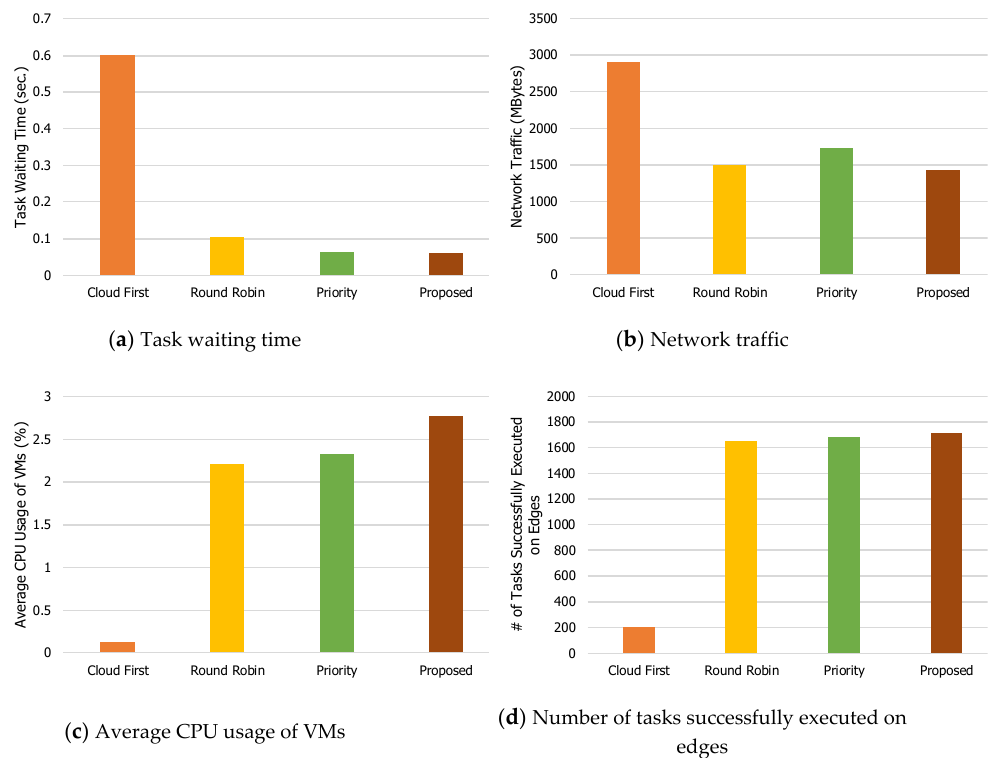
Figure 5. Performance comparisons when the number of mobile devices is 400.